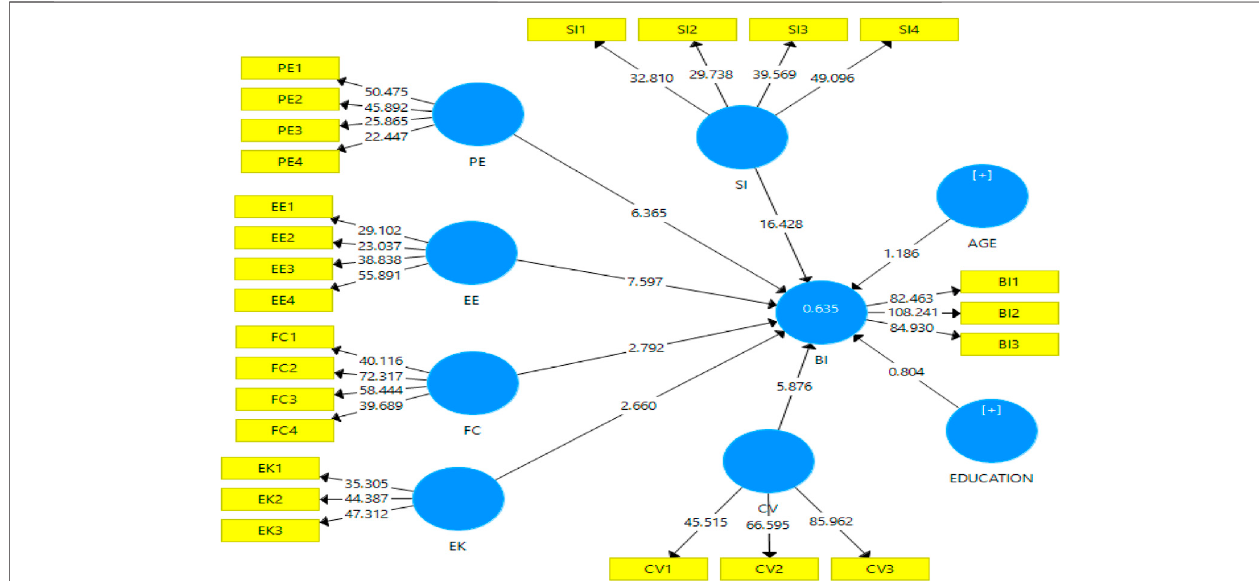
FIGURE 3 | PLS-SEM Path